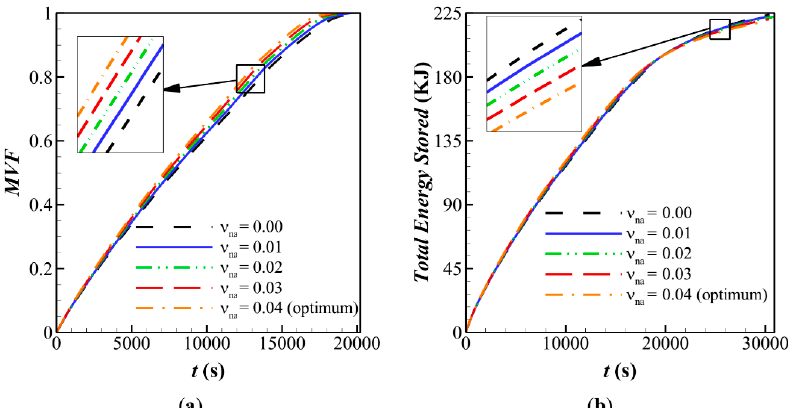
Figure 7. Influence of fin’s angle ( α ) on characteristic parameters when α = 0, AR = 0.675 for: ( a ) melting volume fraction; ( b ) Total energy stored for case